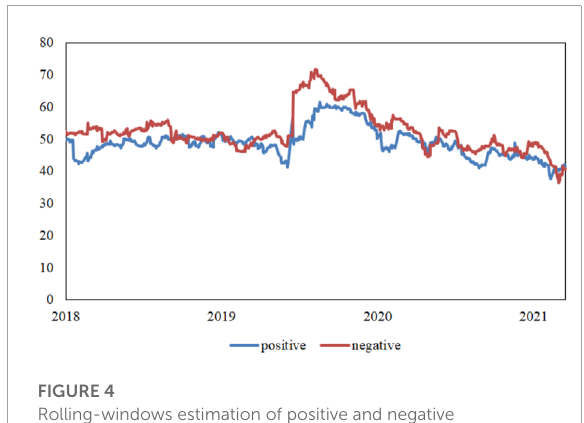
FIGURE 4 Rolling-windows estimation of positive and negative